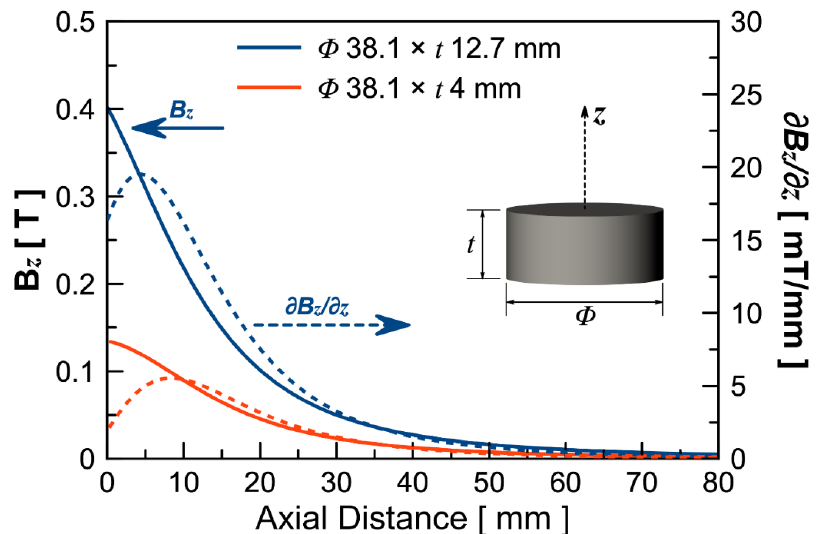
Figure 3. Simulation results of magnetic flux density (solid lines) and magnetic flux density gradient (dotted lines) generated by the external magnet along the axial direction. Blue lines are results for the larger magnet (38.1 mm in diameter and 12.7 mm in thickness) and red lines are results for the smaller magnet (38.1 mm in diameter and 4 mm in thickness).